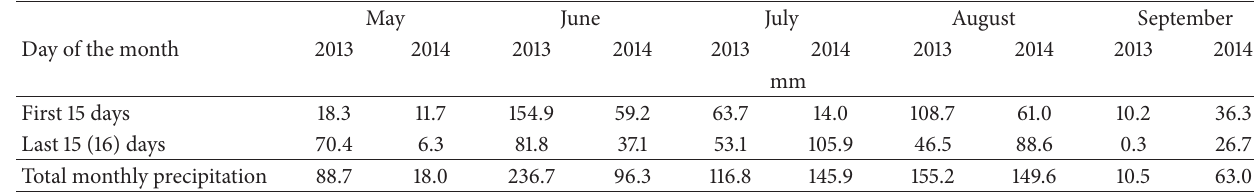
Figure 1: From fore- to background row there are two rows, each of large, medium, and small sized seed varieties, 72 hours after start of germination study. Table 3: Biweekly precipitation during the months of May through September of 2013 and 2014 near Petersburg, VA.